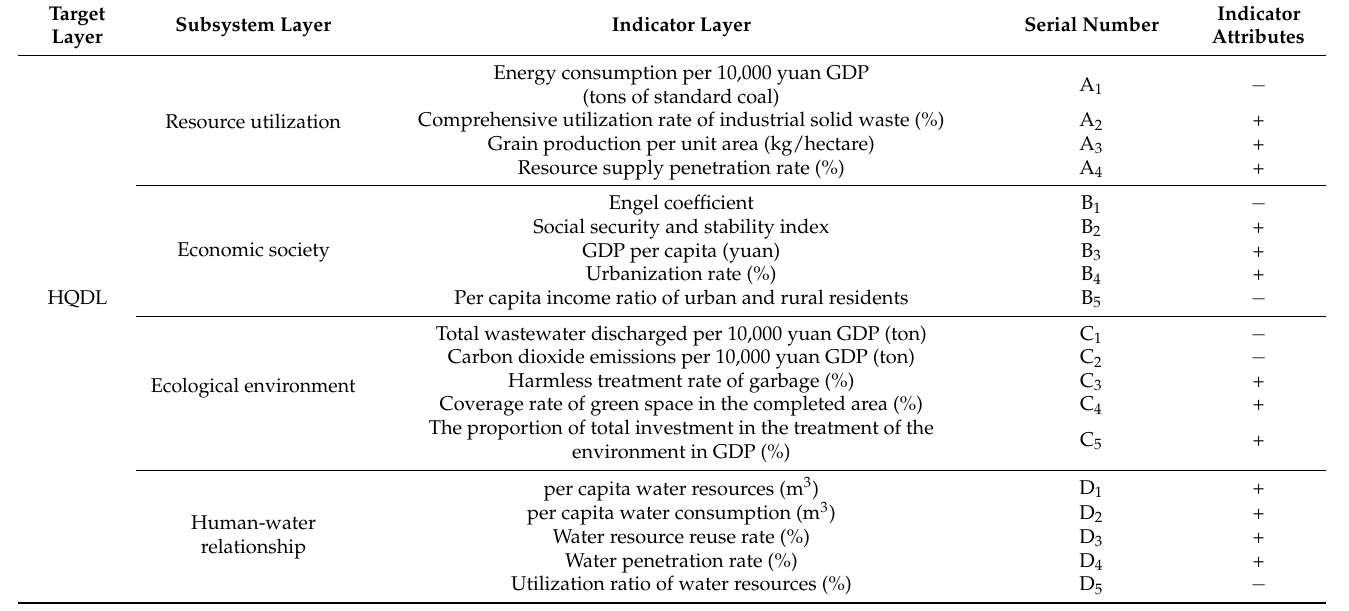
Table 1. Evaluation index system of HQDL considering water constraints (+ and − indicate positive and negative indicators respectively).